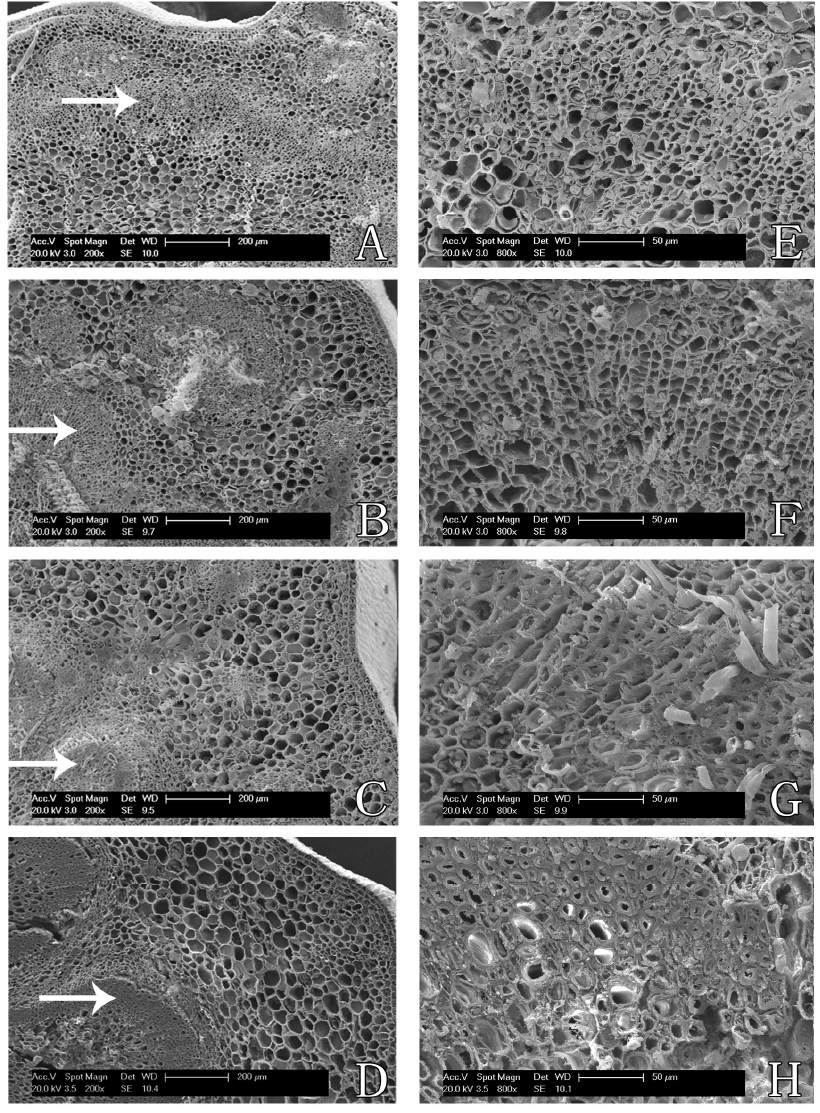
Figure 2. Observation of inflorescence stem microstructure with scanning